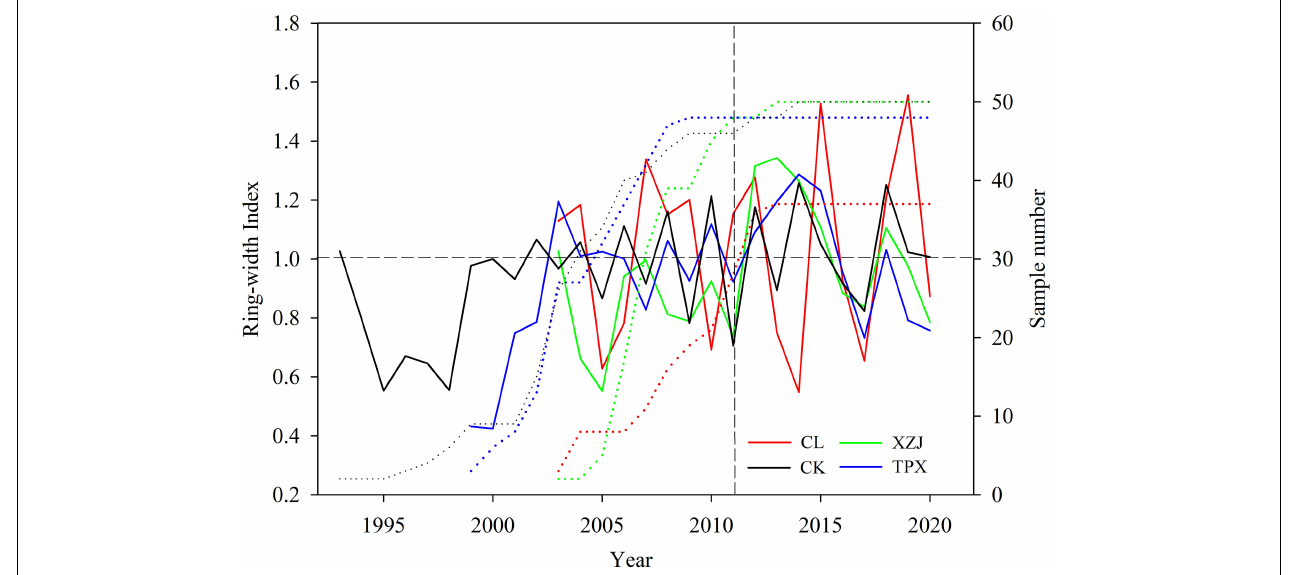
FIGURE 4 | The ring-width chronologies at the four sampling sites after detrending (solid lines represents ring-width index, dotted lines represent sample number).